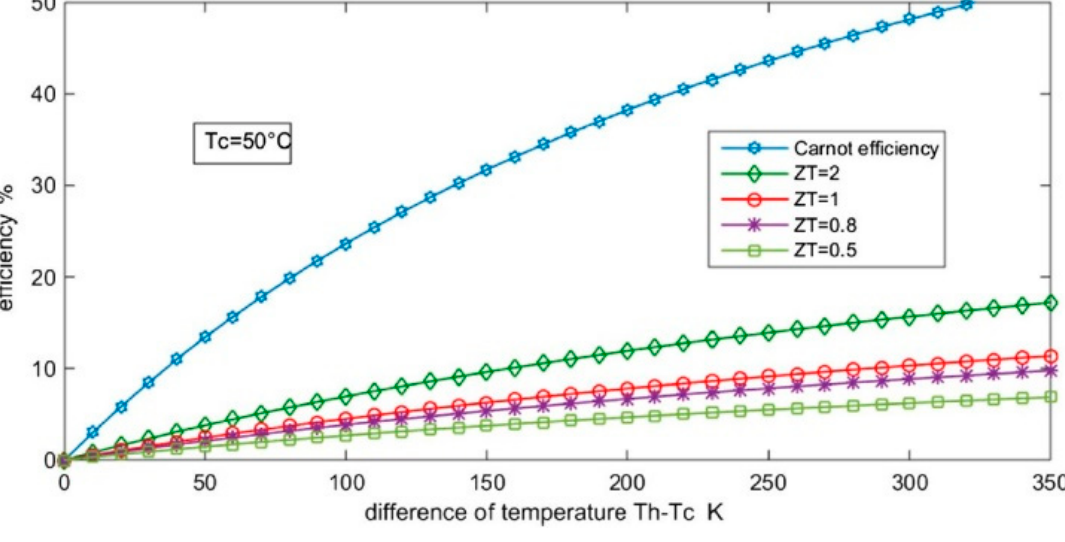
Figure 2. Variation of TEM efficiency for different ZT [9].